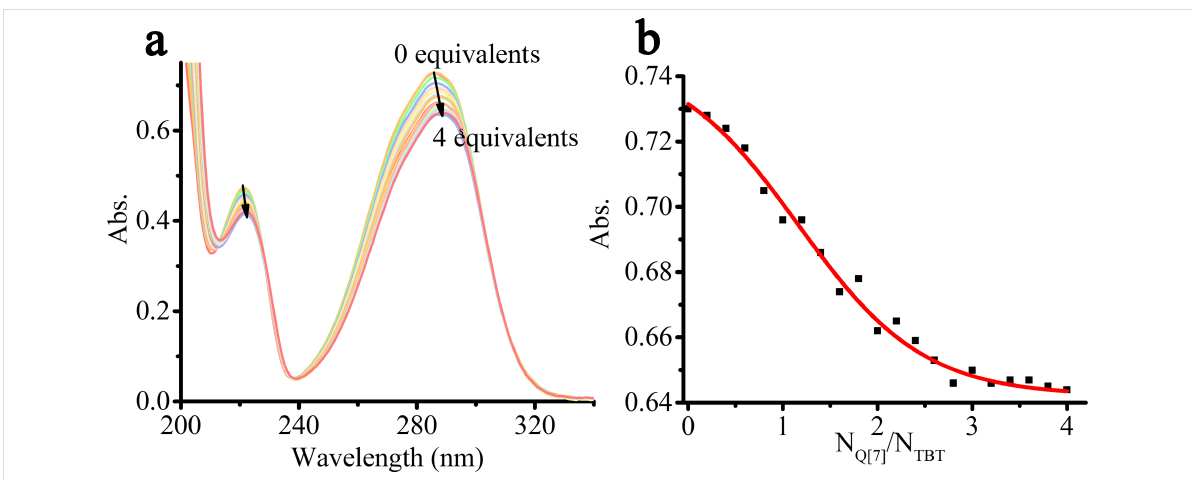
Figure 3: The UV–vis spectra (a) of TBT (20 μ M) with an increasing amount of Q[7] from 0.0 to 4.0 equiv; the plots (b) of N Q [7]/N TBT vs absorbance of TBT in water at λ = 286